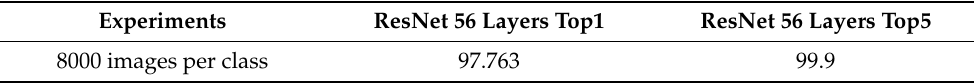
Table 4. ResNet 56 experiment: top 1 and top 5 accuracy (%) results with 8000 images per class.